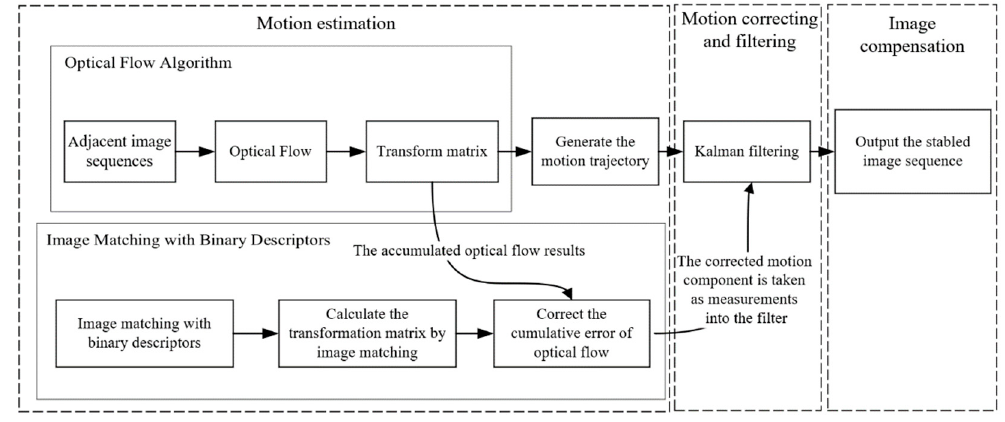
Figure 1. Block diagram of the proposed framework.